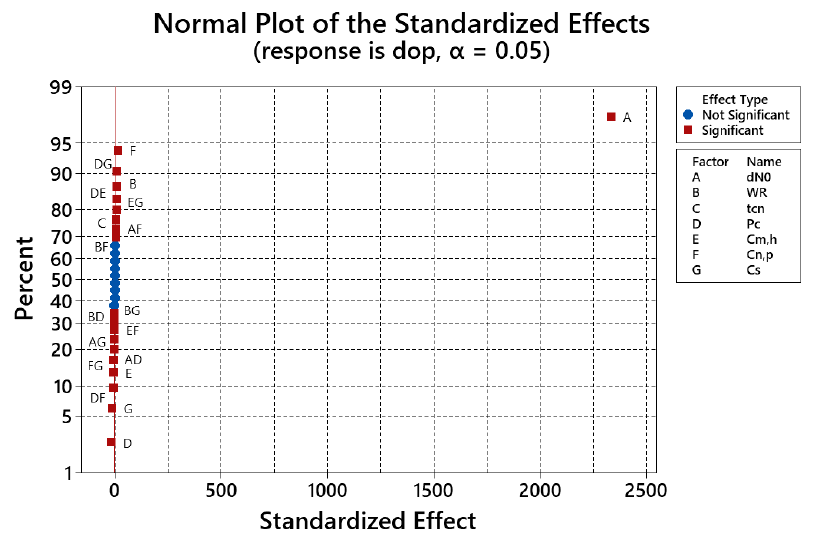
Figure 9. Normal plot for d op .